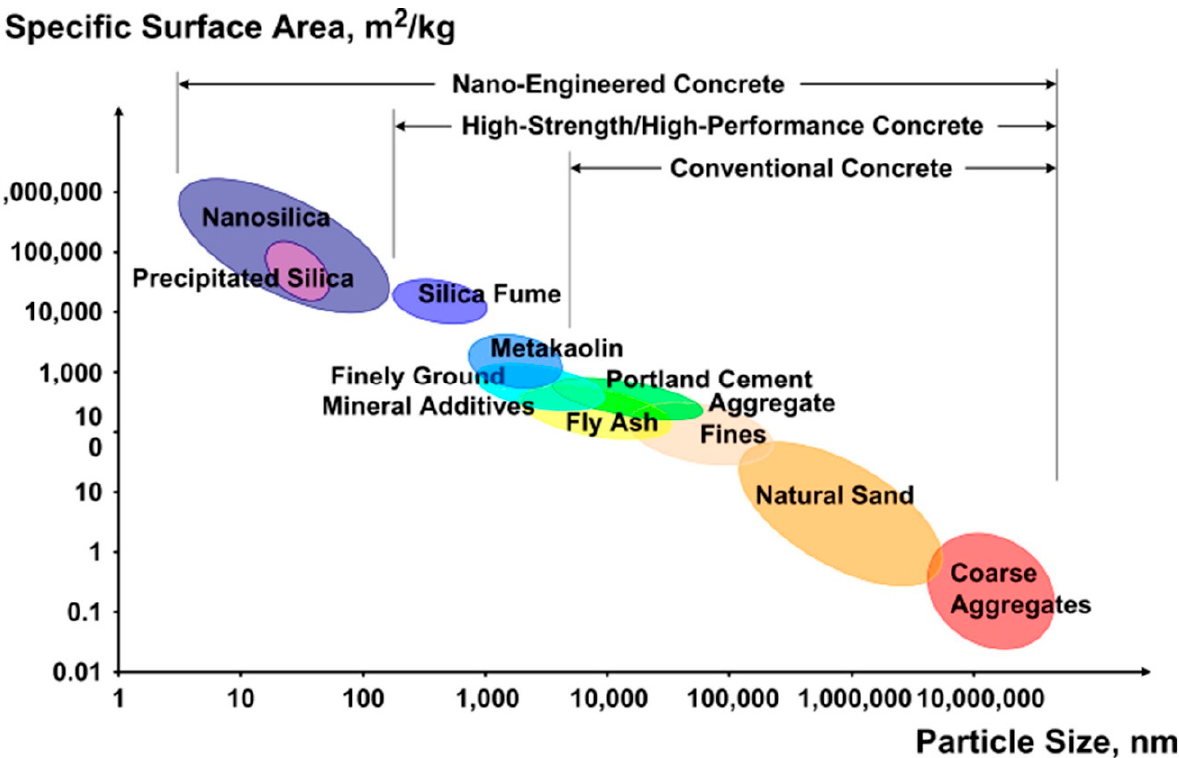
Figure 1. Particle size and SSA related to cementitious materials [58].